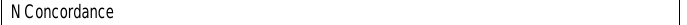
Figure 3. Comparison by relative percentage terms between high-frequency exhortatory language items in Qcorpus1 and Qcorpus2.